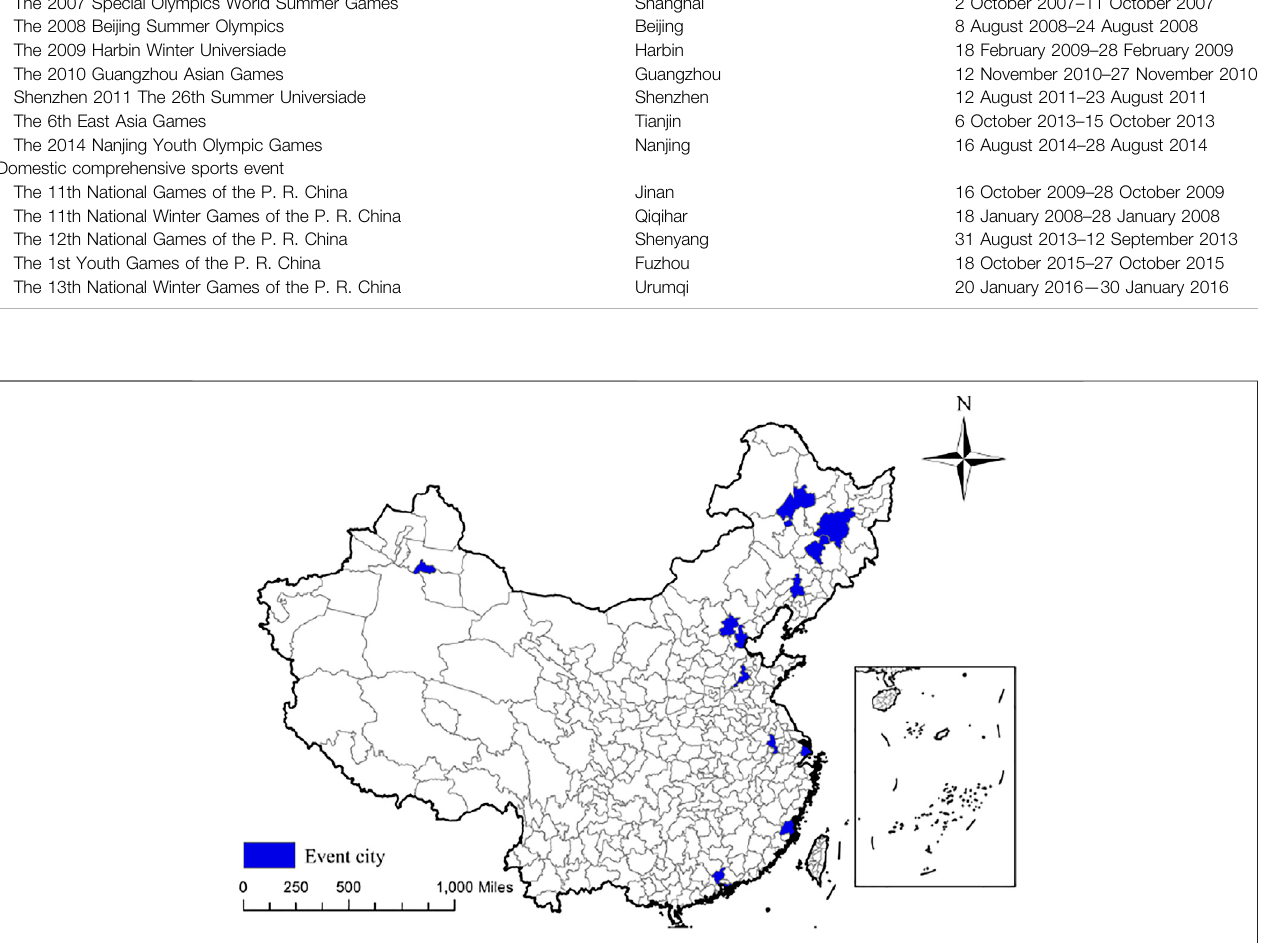
FIGURE 1 | Spatial distribution of cities hosting comprehensive sports events.